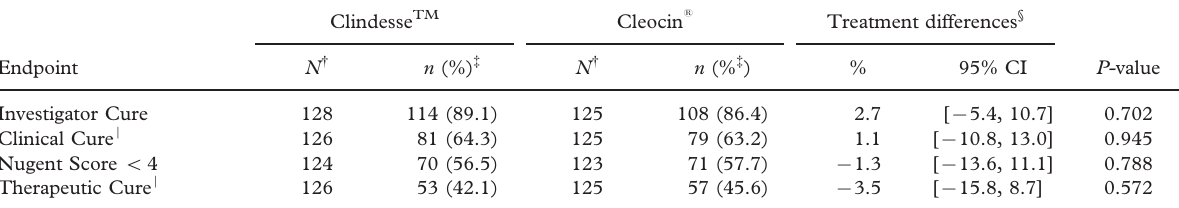
Table II. Efficacy outcomes at the Test-of-Cure Visit (number and % of evaluable patients cured). Clindesse TM Cleocin 1